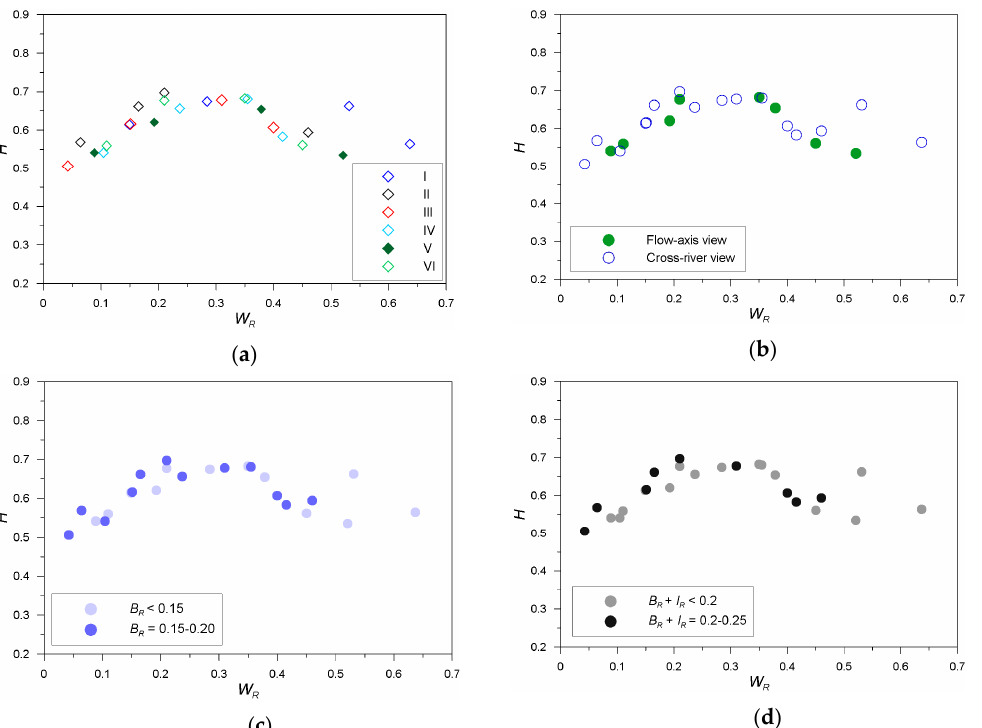
Figure 5. Relationship between harmony ( H) and amount of visible water ( W R ) for different sites and views, for various values of the ratio of visible buildings B R , and the proportion of visible buildings and infrastructure ( B R + I R ). ( a ) Different sites. ( b ) Different views. ( c ) Various values of proportion of visible buildings B R . ( d ) Various values of proportion of visible buildings and infrastructure ( B R and I R ).